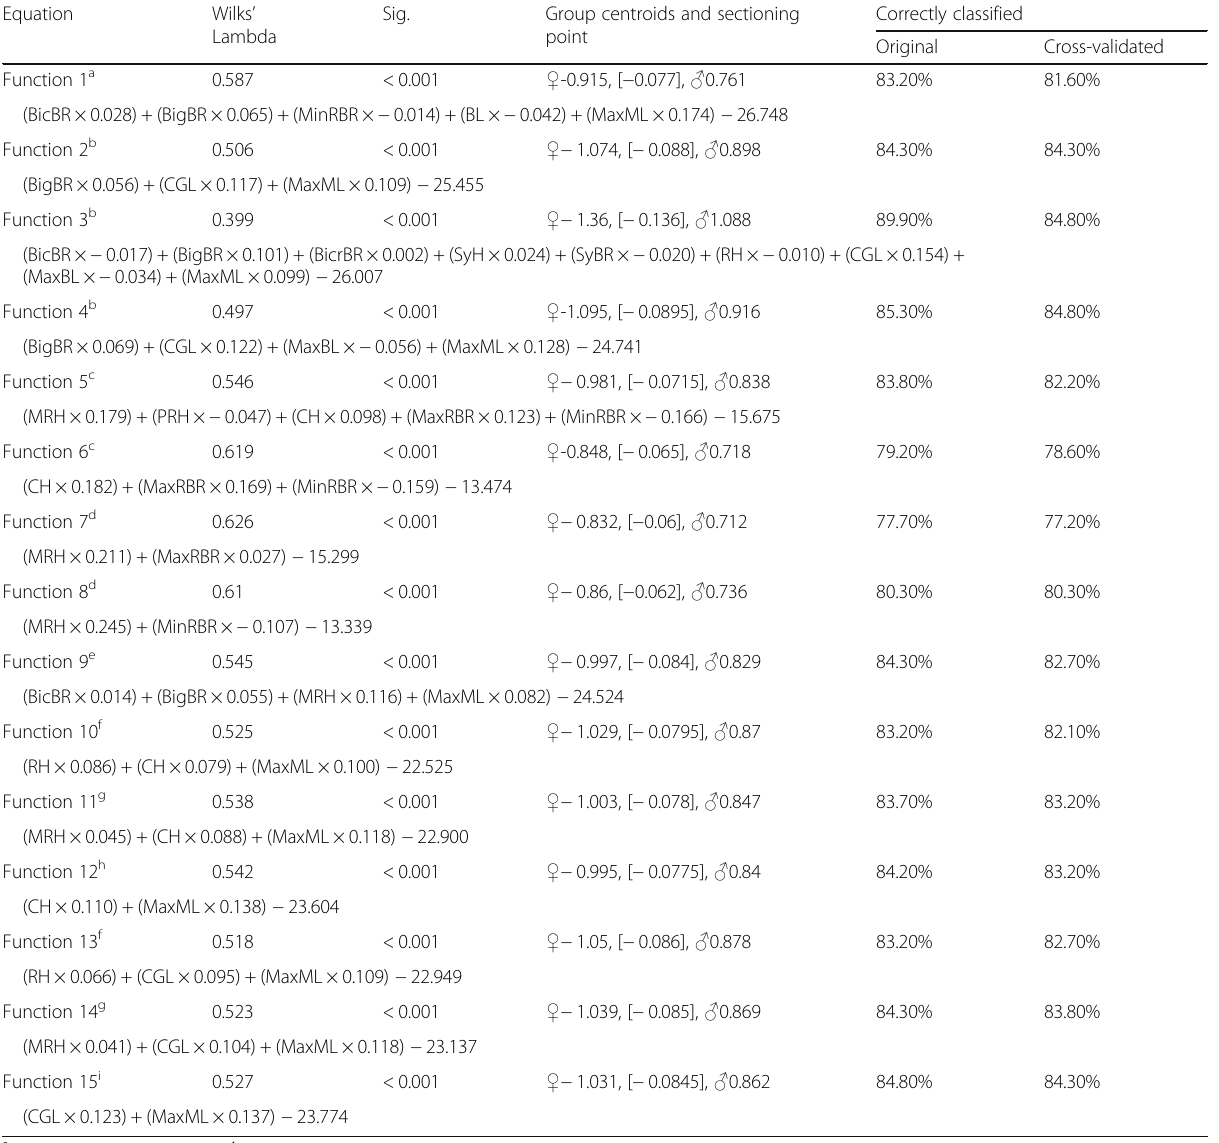
Table 6 Discriminant functions based on the left-side measurements Equation Wilks ’ Sig. Group centroids and sectioning Lambda point